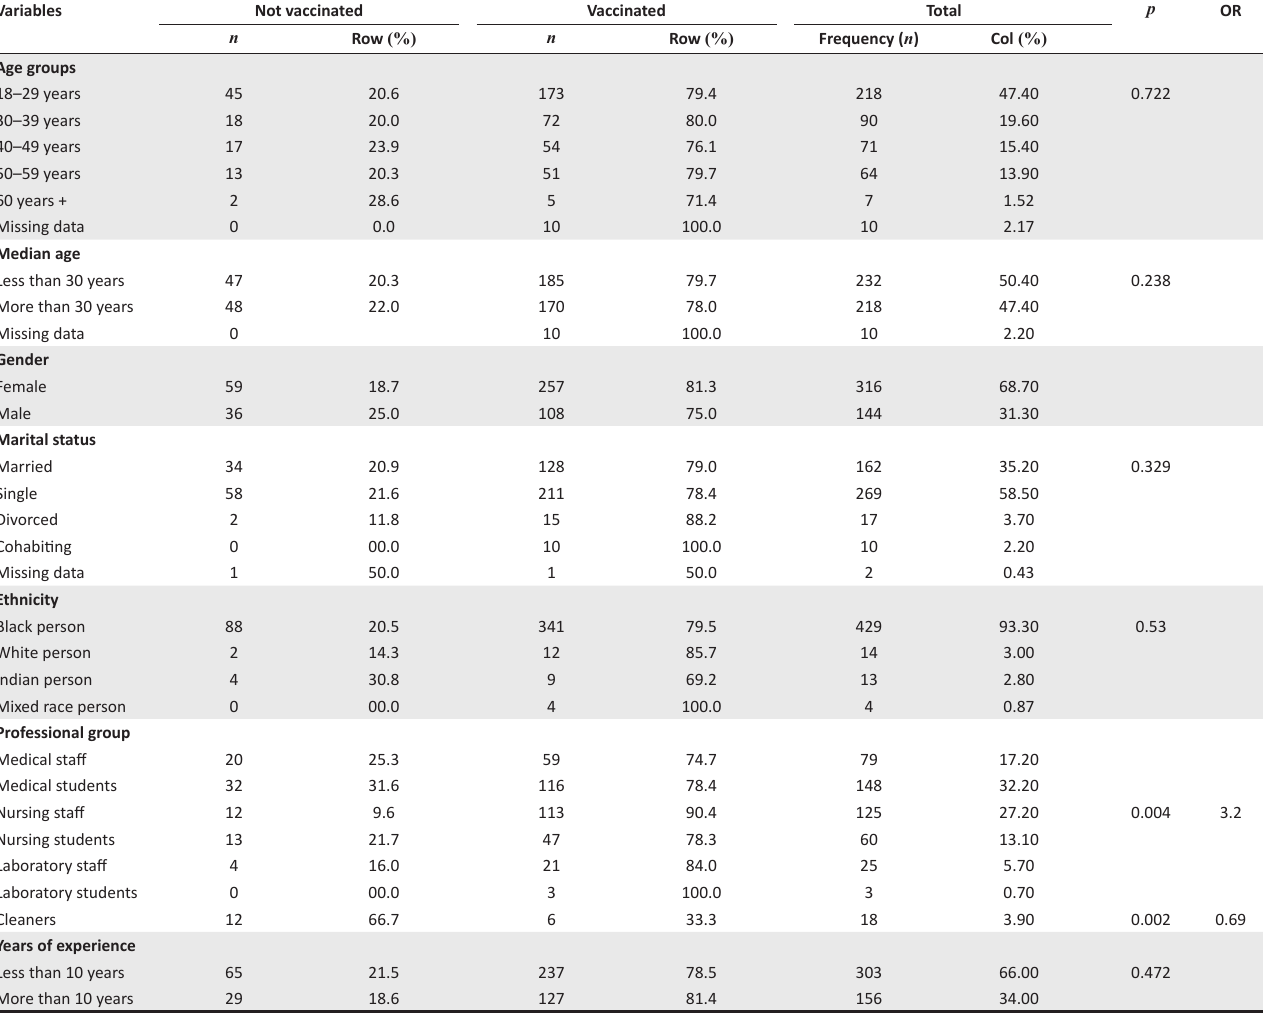
TABLE 2: Demographic characteristics of healthcare workers. Variables